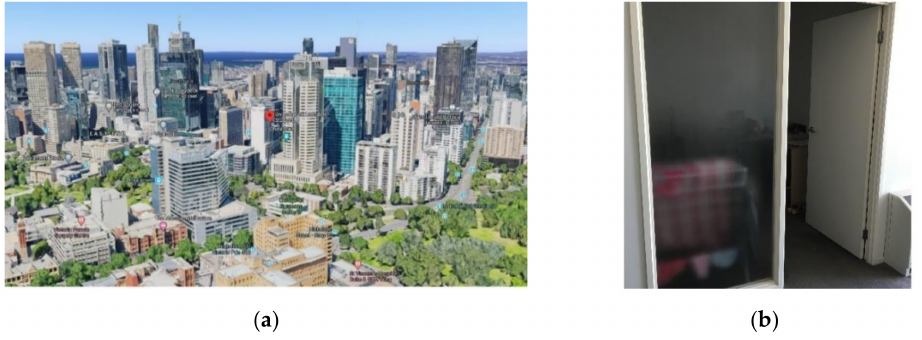
Figure 1. ( a ) High rise apartments in Melbourne. ( b ) Light borrowed from the living